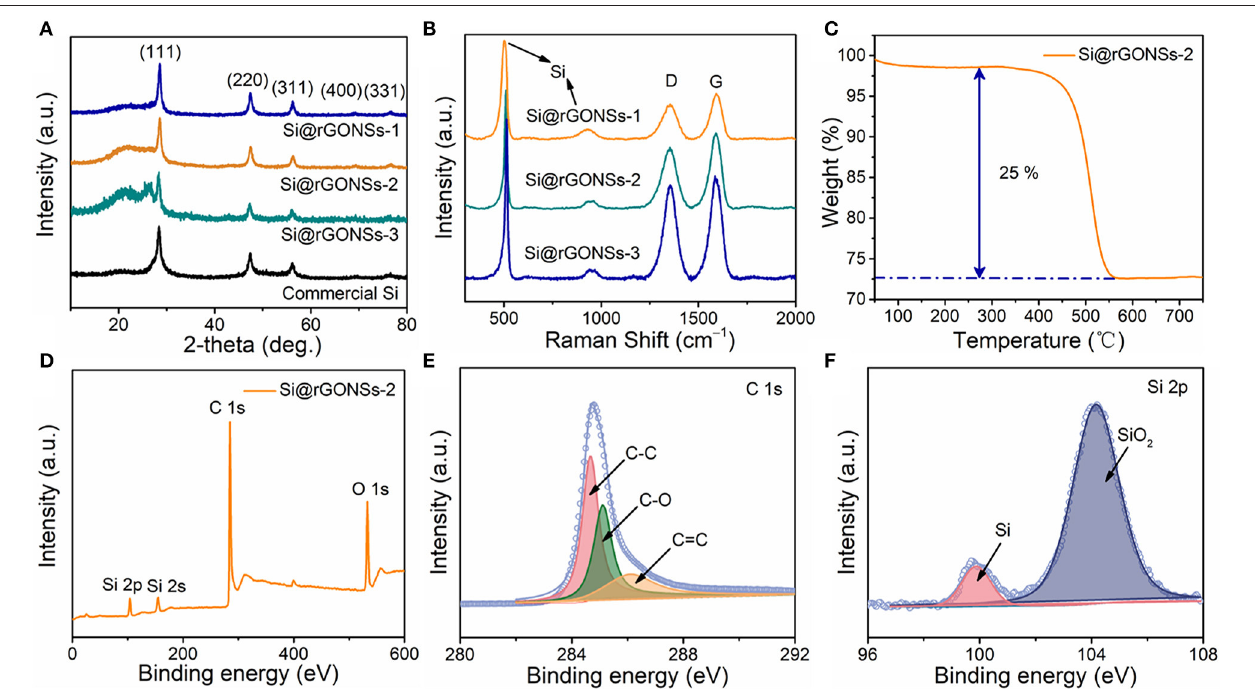
FIGURE 2 | (A) XRD patterns and (B) Raman spectrum of Si@rGONS composites, (C) thermogravimetric analysis (TGA) data of Si@rGONSs-2, (D) XPS survey spectrum of Si@rGONSs-2, and (E,F) high-resolution C 1s and Si 2p spectrum of Si@rGONSs-2.